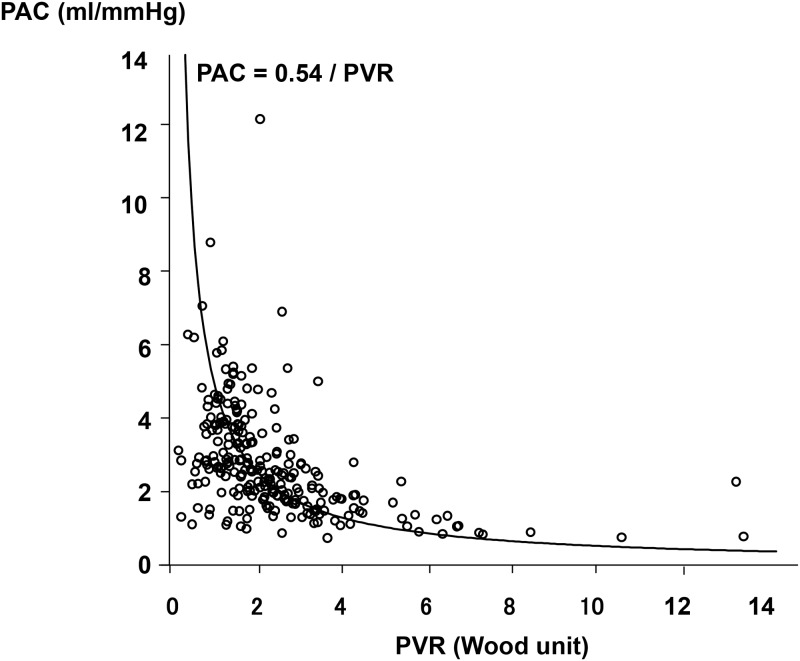
Scatterplot of PVR vs. PAC.There was a hyperbolic relationship between PAC and PVR. PVR, pulmonary vascular resistance; PAC, pulmonary arterial capacitance.